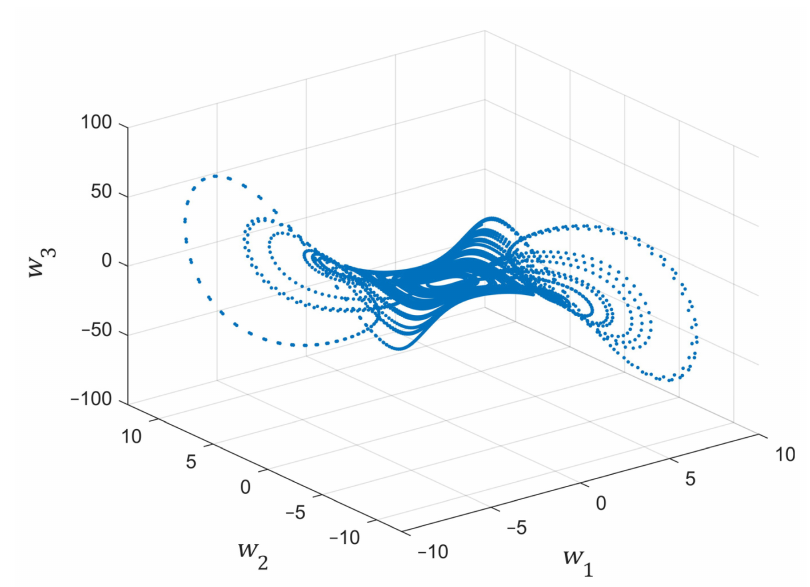
Figure 7. State–space trajectories of 3D Jerk system for initial condition w = [ 1 0 0 ] T .